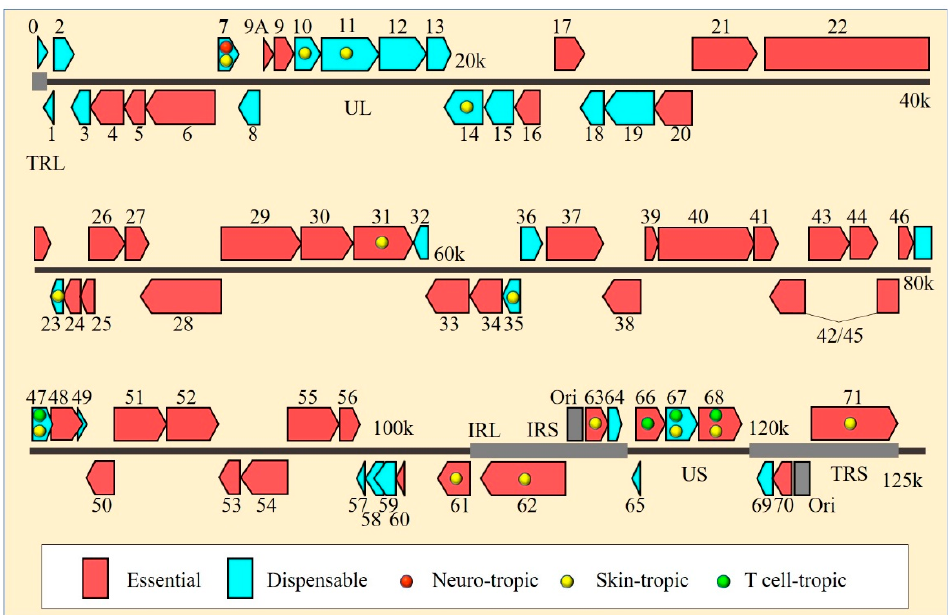
Figure 1. Genome-wide map of VZV genes required for virus replication and tissue tropism. Genomic arrangement of the open reading frames (ORFs) is based on the complete genome sequence of VZV pOka strain. VZV ORFs are colored according to their essentiality for virus growth in human melanoma cells, epithelial cells or fibroblasts in vitro. Essential and dispensable ORFs with functional domains that determine VZV tropisms are labeled with differently colored filled circles, depending on their specific function in human dorsal root ganglia (DRG), skin and T cells in vivo. The image is adapted with modifications from reference [32].